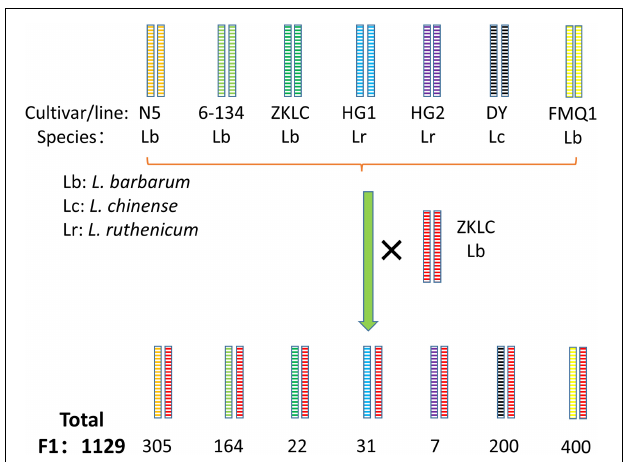
FIGURE 6 | Construction of NAM population in Lycium . cultivar/line of L. barbarum : N5, 6-134, ZKLC, FMQ1; cultivar/line of L. chinense : DY; cultivar/line of L. ruthenicum : HG1, HG2; × :